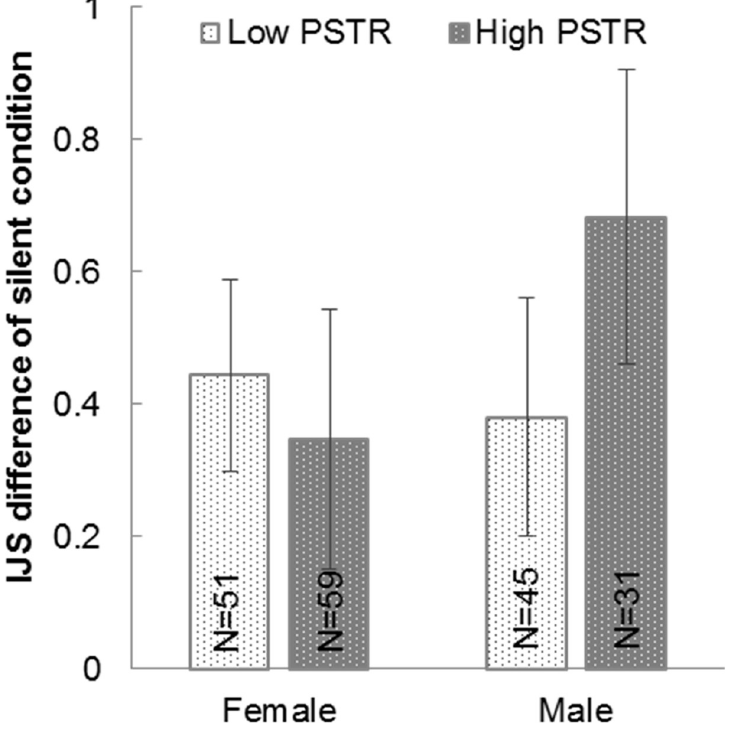
Fig 8. IJS difference between low and high PSTR groups obtained for each gender under the silent condition.